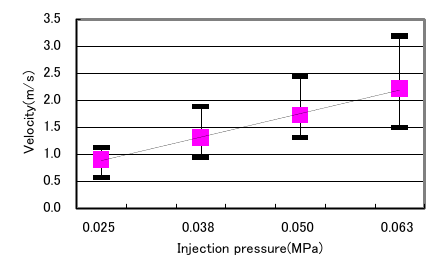
Fig. 6 Relation between injection pressure and growth velocity of